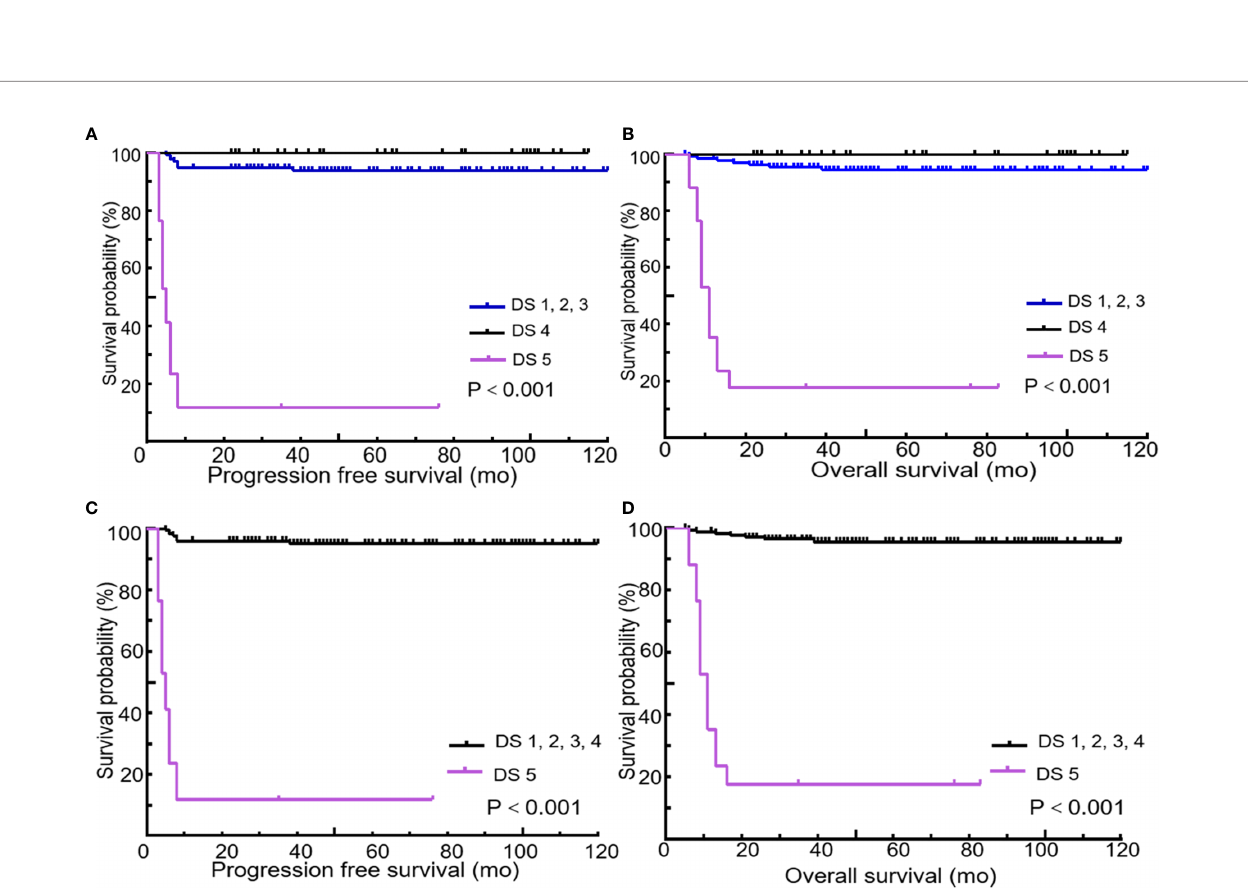
FIGURE 5 | Kaplan-Meier curves of PFS and OS according to end of treatment PET/CT results using different cutoff values of the Deauville score (Cutoff at 1 to 3 vs. 4 vs. 5 or 1 to 4 vs. 5). Cutoff at 1 to 3 vs. 4 vs. 5 for PFS (A) and OS (B) . Cutoff at 1 to 4 vs. 5 for PFS (C) and OS (D)